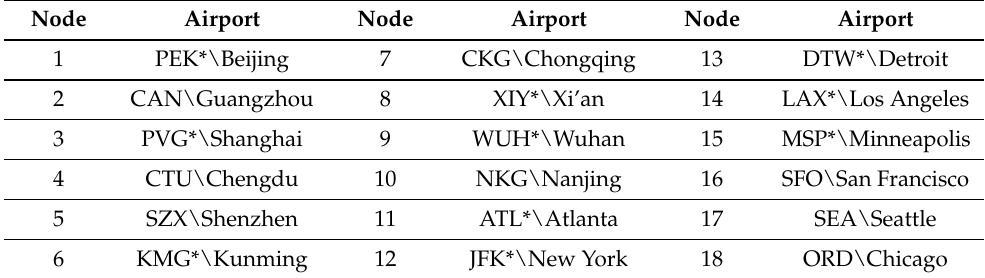
Table 1. Citys airport.